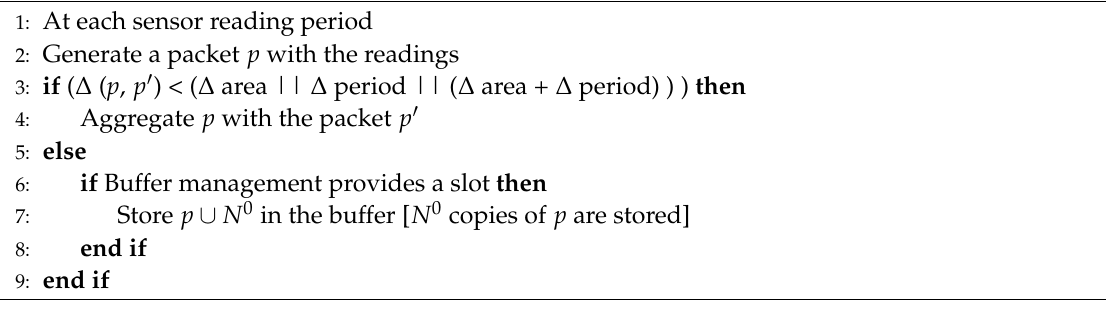
Algorithm 2 Generation phase : IoB-DTN based on data aggregation.